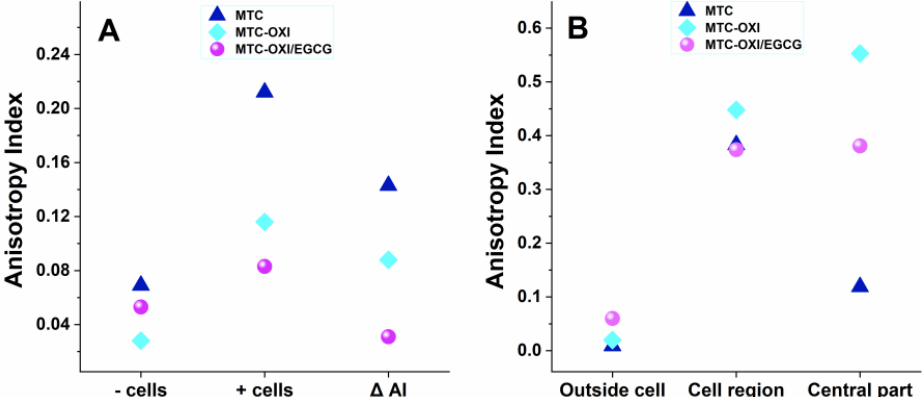
Figure 5. Panel ( A ). Anisotropy index of FITC labelled collagen samples, consisting of native (MTC), oxidized (MTC-OXI), and MTC-OXI pretreated with EGCG (MTC OXI/EGCG), measured for bare samples ( − cells) and for samples (+cells). The change of anisotropy index by the cells is presented as ∆ AI. Panel ( B ). More detailed measurements of the same parameters were performed in the selected regions of interest (ROI): “Outside the cells”, the “Cellular region” and the “Central part” including the nuclear/perinuclear cell region.